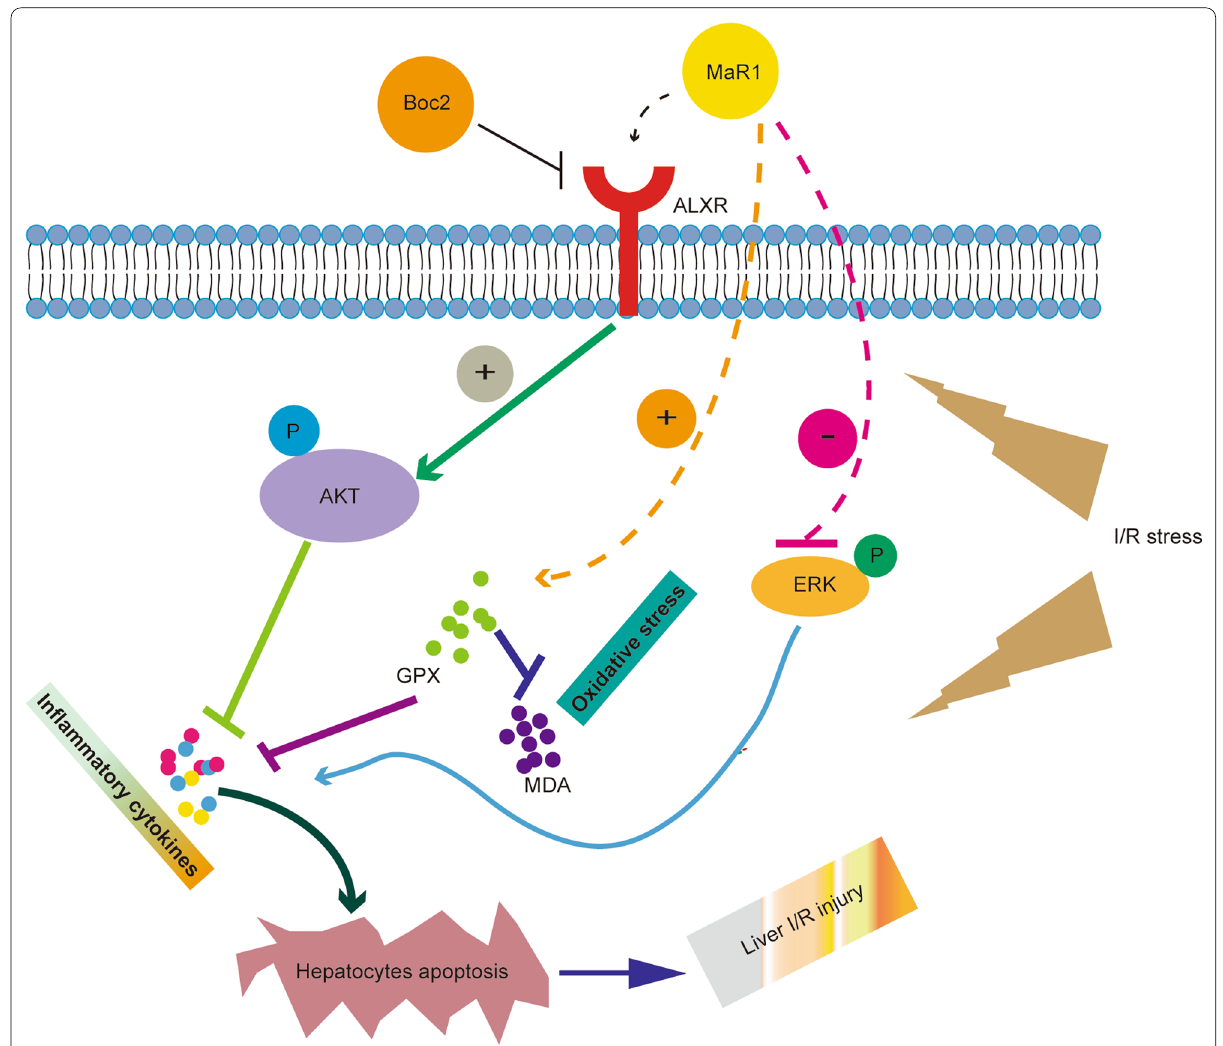
Fig. 7 Proposed hepatoprotectivesignaling mechanisms mediated by MaR1 in liver I/R injury. MaR1 confersprotection against I/R-induced liver damage through interacting with ALXR, thusresulting in enhancing downstream p-Akt protein expression. MaR1 also exertsits protective role during hepatic I/R injury by increasing antioxidant enzymeactivity (GPX), inhibiting the activation of ERK and suppressing inflammatoryresponses, and finally contributes to decreased apoptotic cell